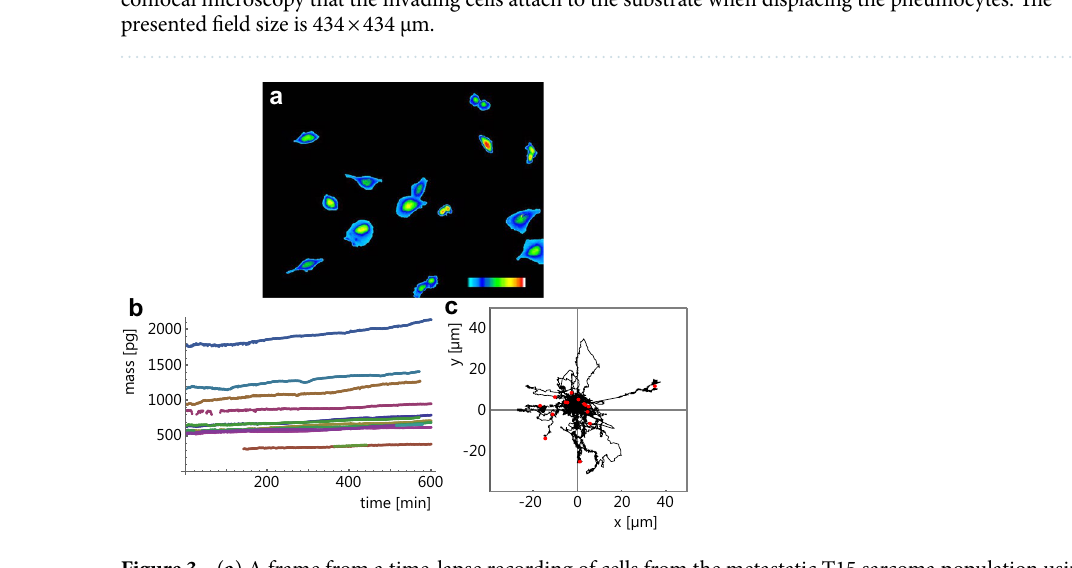
Figure 3. ( a ) A frame from a time-lapse recording of cells from the metastatic T15 sarcoma population using a Horn type Leitz double beam transmitted-light interference microscope equipped with a 20 × twin objective lens and an Orca ER camera (Hamamatsu). The field size is 634 × 483 µm. The pseudo-color bar represents a range of dry-mass densities from 0 to 2.1 pg µm −2 . ( b ) Growth curves of individual cells and clusters of cells from the recording. ( c ) Rose plot of trajectories of mass centroids of cells from the recording. Each trajectory was positioned with its starting point in the origin, and the endpoint is marked with a red